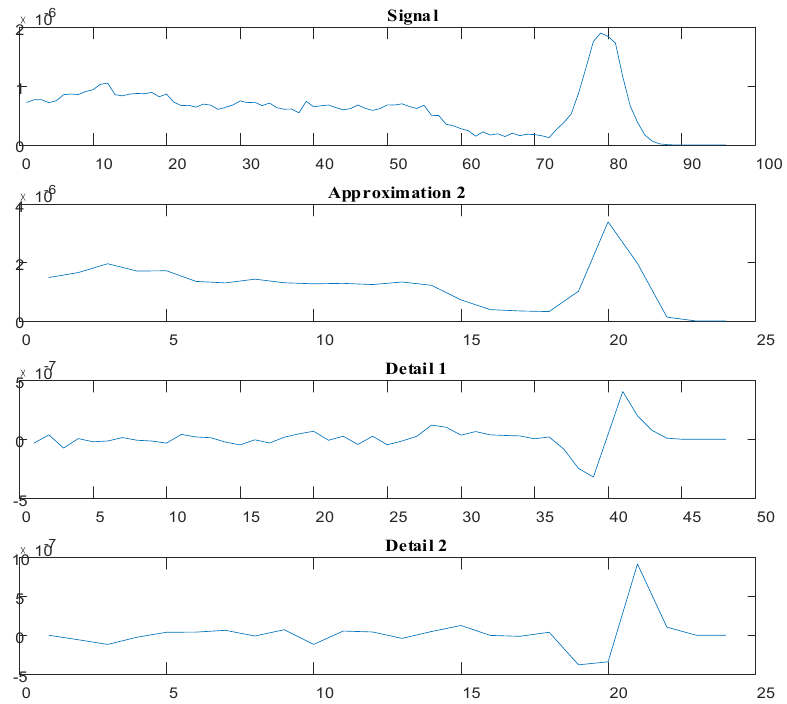
Figure 3. Wavelet transform of the first detector’s signal for the annular regime with a void fraction of 5%.